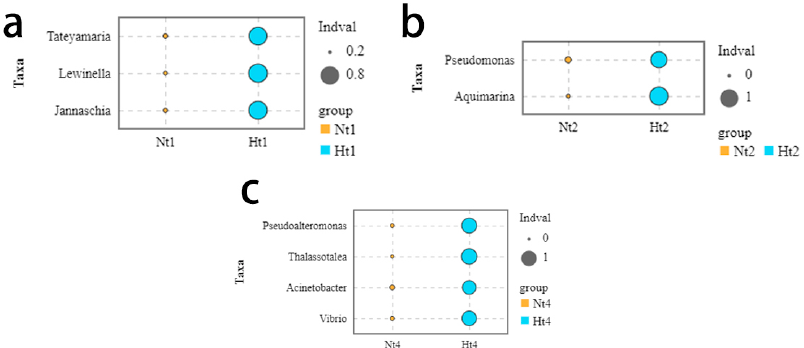
Figure 6. Extremely significant indicator genera at elevated temperature level. The horizontal and vertical axes represent different groups and indicator genera, respectively. The size of the bubbles in the figure represents the IndVal of the species between the Nt and Ht groups. Orange and blue represent the Nt group and the Ht group, respectively. Nt: normal seawater temperature; Ht: 3 °C higher temperature. ( a – c ) May, June, and August respectively. No highly significant indicator genera ( p ≤ 0.05, Indval ≥ 0.7, relative abundance >0.3) were found in July in any of the groups.